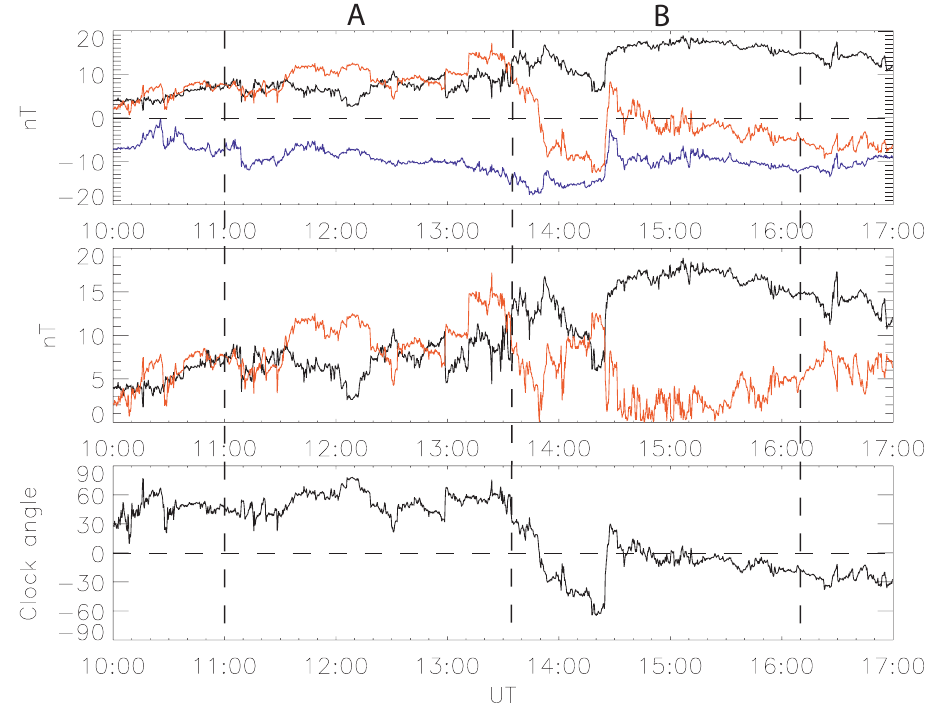
Fig. 2. The IMF conditions observed by the ACE spacecraft from 10:00 to 17:00 UT on 22 December 2002. A 55min delay time has been added to the plots. The IMF B x component is coloured blue, the IMF B y component is coloured red and the IMF B z component black. Time intervals A and B are indicated on the plot by the vertical dashed